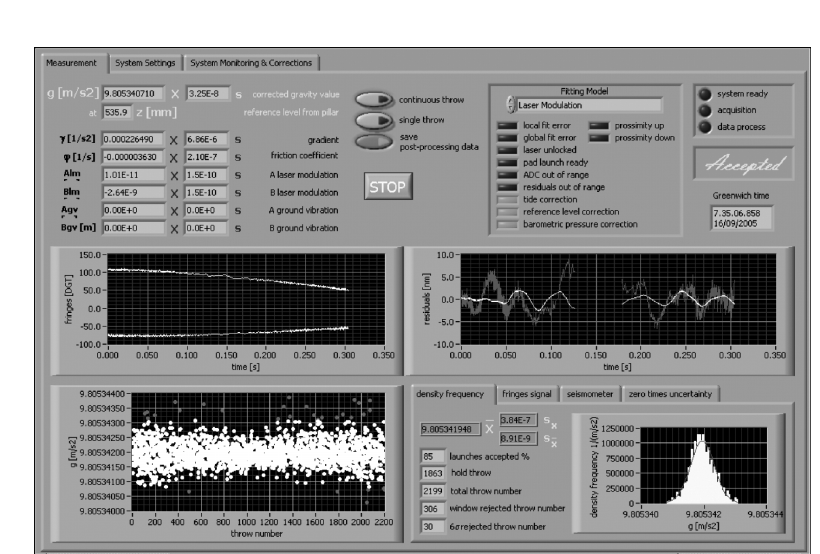
Fig. 5. User interface panel of the Gravisoft M